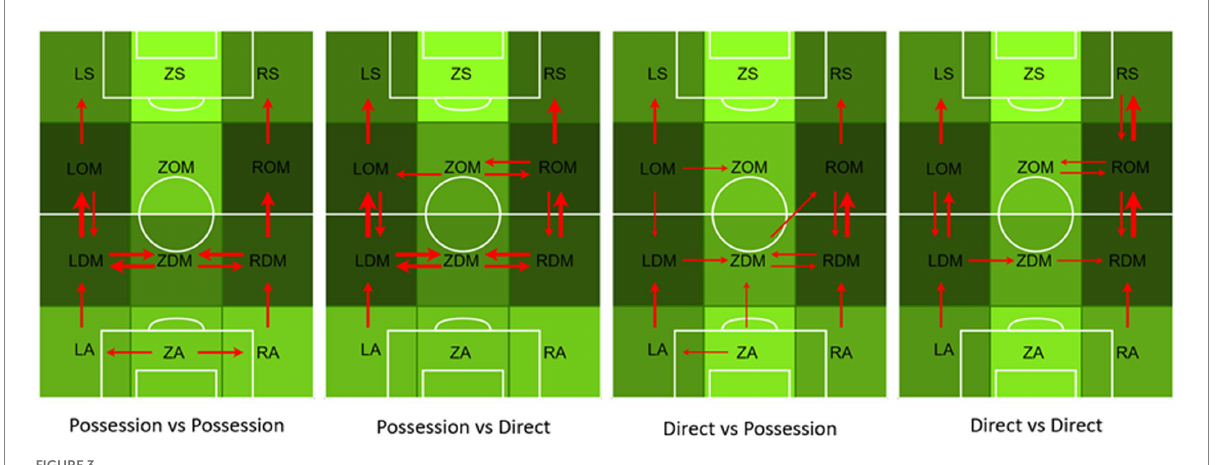
FIGURE 3 Descriptive analysis of actions zones and passing paths among top three teams in the World Cup